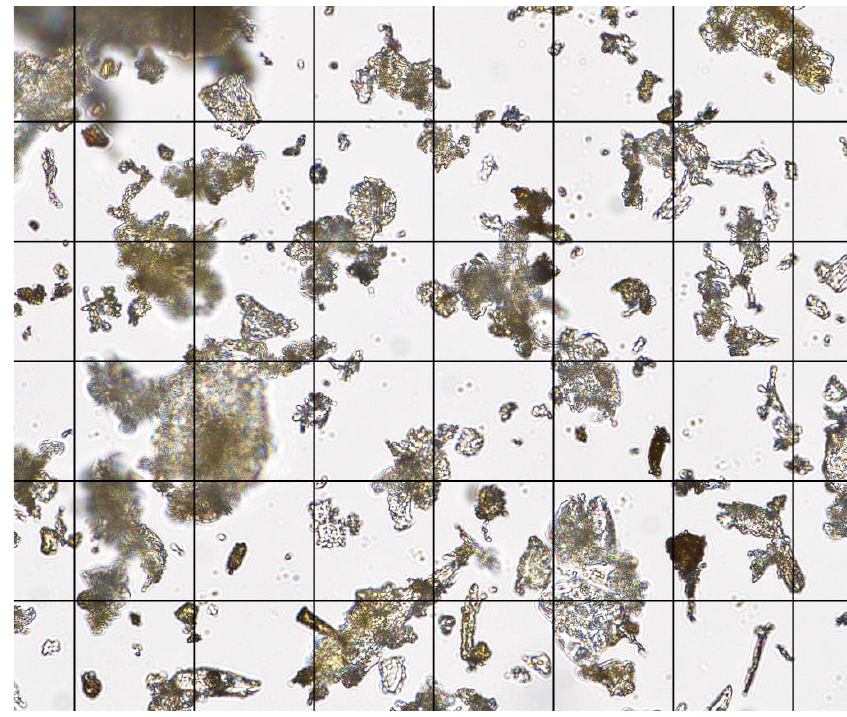
Figure 9. Image showing red oak dust particle shape and size on a 50-micron grid.